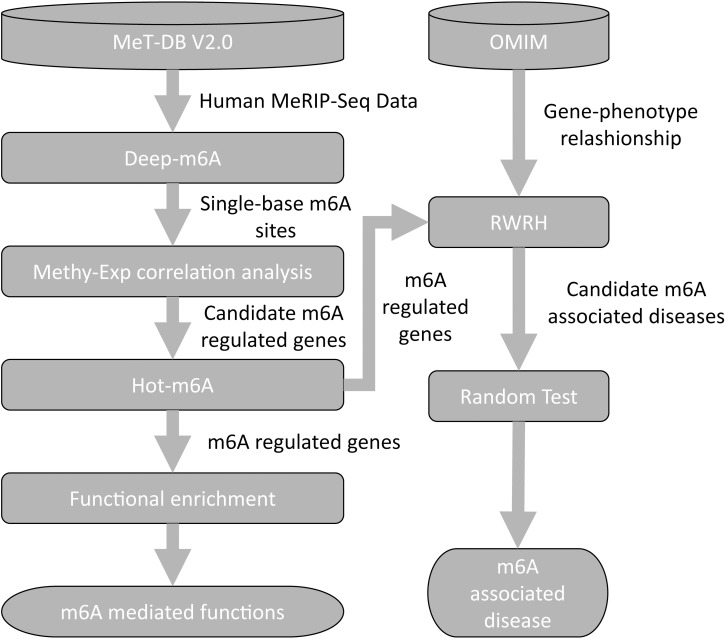
Flowchart of our proposed prediction pipeline.